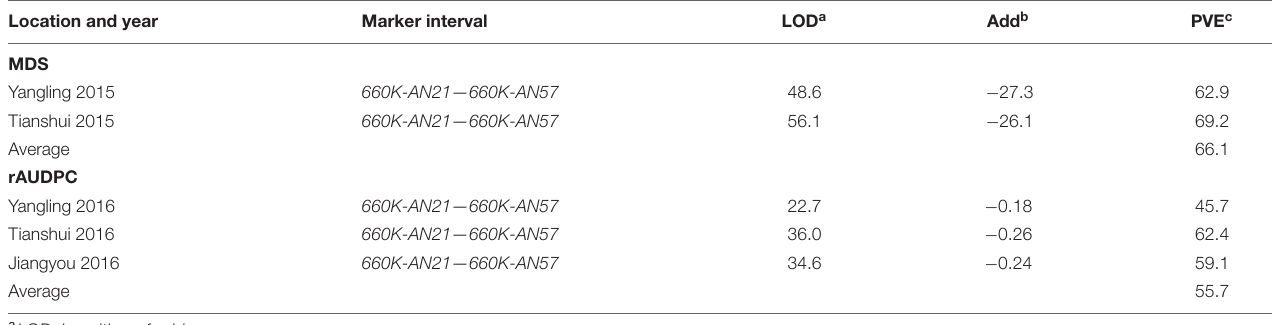
TABLE 3 | Summary of stripe rust resistance QTL detected by ICIM in the AvS × Napo 63 F 2 : 3 population across two environments and F 5 : 6 population across three environments. Location and year